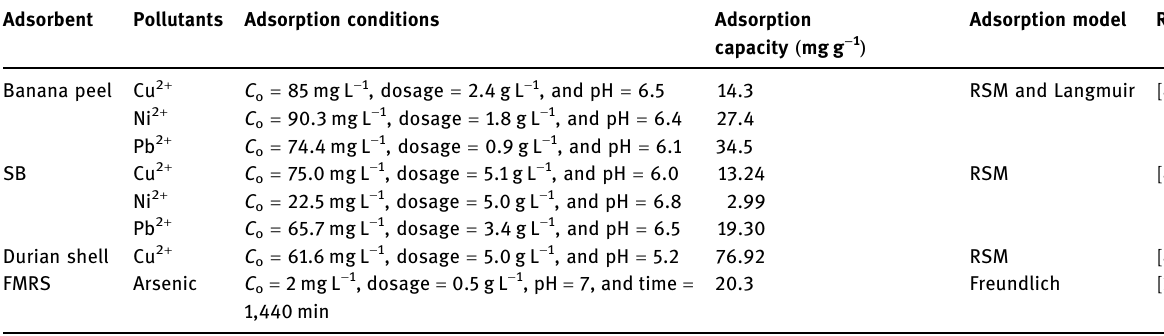
Table 5: Optimum conditions for AC from bio - waste in heavy metal treatment Adsorbent Pollutants Adsorption